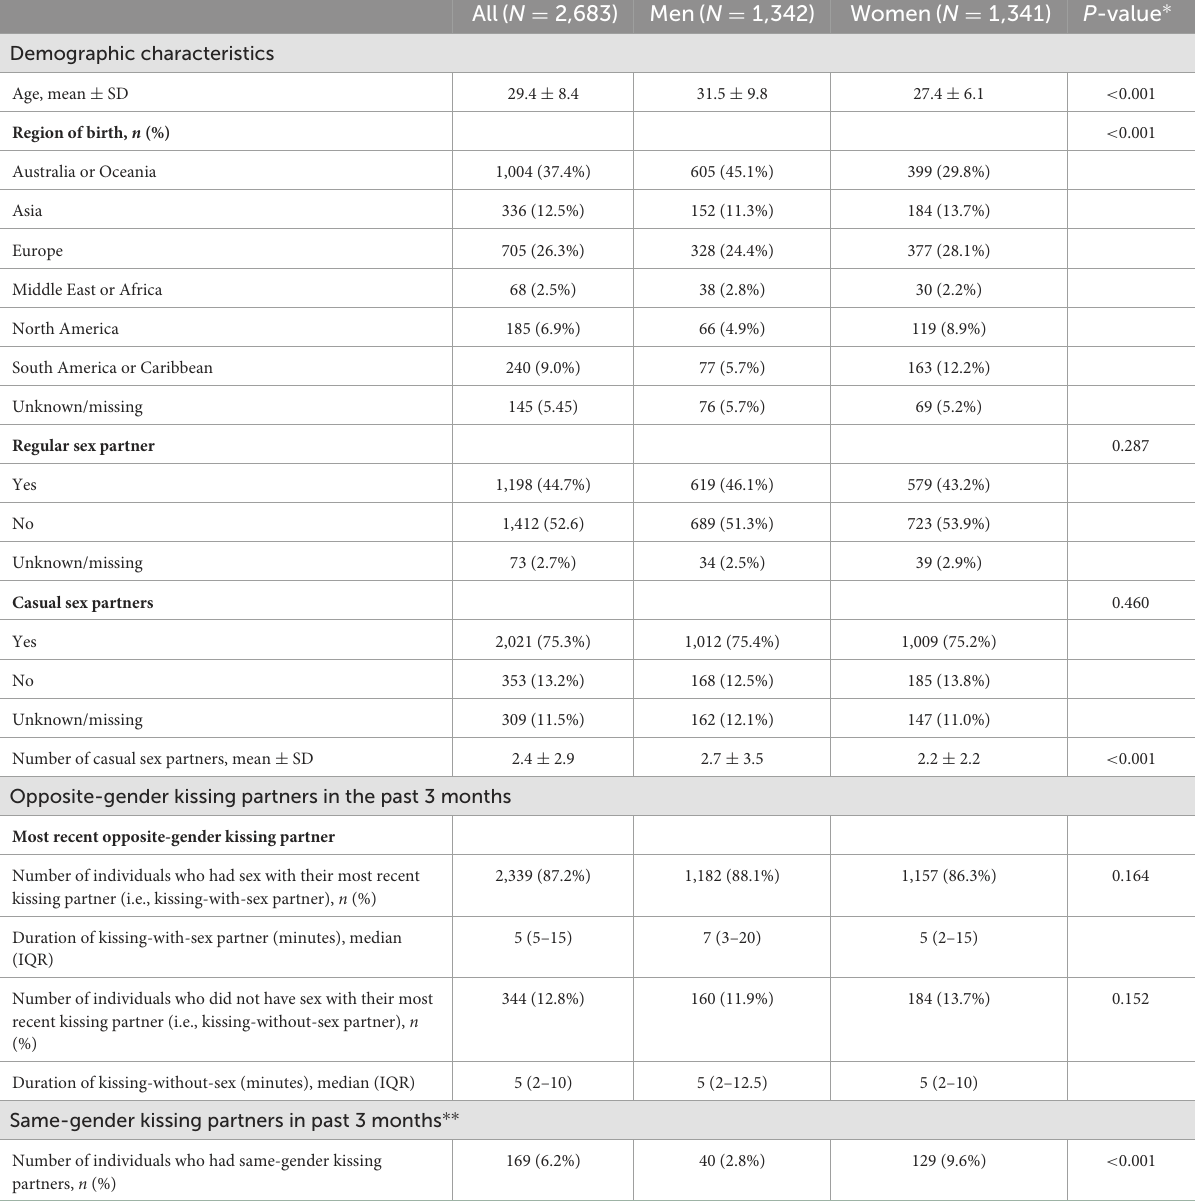
TABLE 1 Demographic characteristics and duration of kissing among 2,683 heterosexual men and women in the past 3